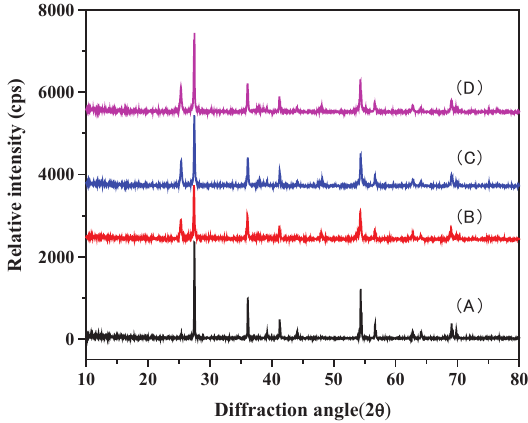
Figure 1: XRD patterns of (A) undoped TiO